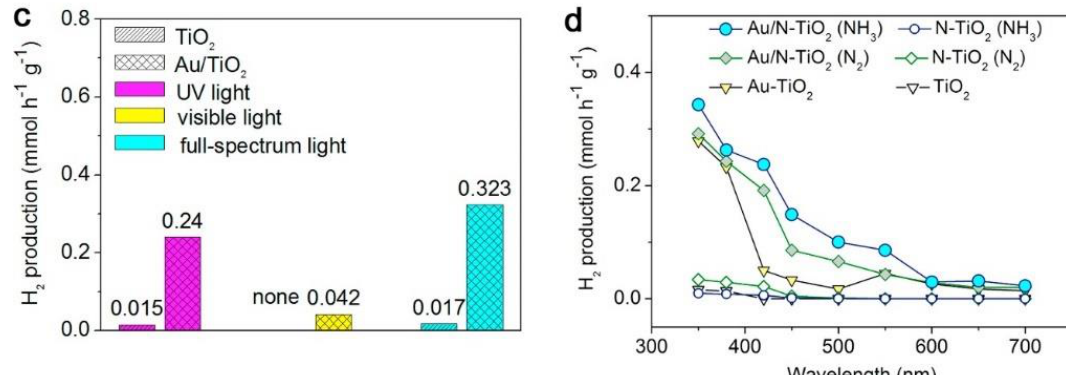
Figure 25. Photocatalytic hydrogen evolution, as presented by Wang et al. [280] for bare and composite bowl nanoarray and nanoparticle structures including TiO 2 , N-doped TiO 2 , Au-nanoparticles-confined n-doped TiO 2 under different irradiation conditions (UV, Visible, and full-spectrum light): ( a ) for structures annealed in NH 3 , ( b ) for structures annealed in N 2 , and ( c ) for un-doped structures. ( d ) In all cases the plasmonic composite bowl nanoarray structures provide higher H 2 production rates as opposed to the bare counterparts in TiO 2 , and N-doped TiO 2 photocatalysts. Reprinted with permission from Ref [280] Copyright Elsevier (2016).